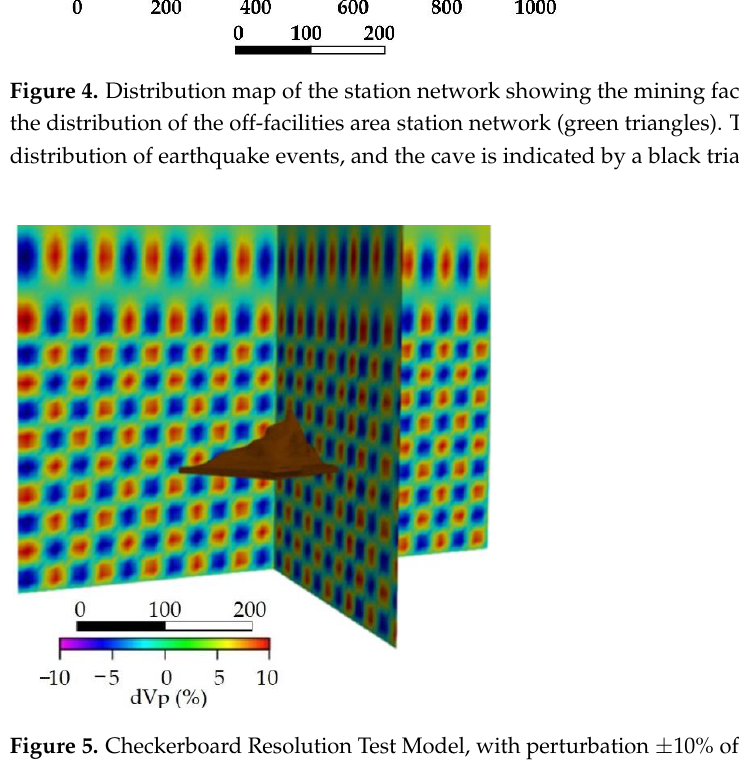
Figure 5. Checkerboard Resolution Test Model, with perturbation  10% of the initial velocity model.